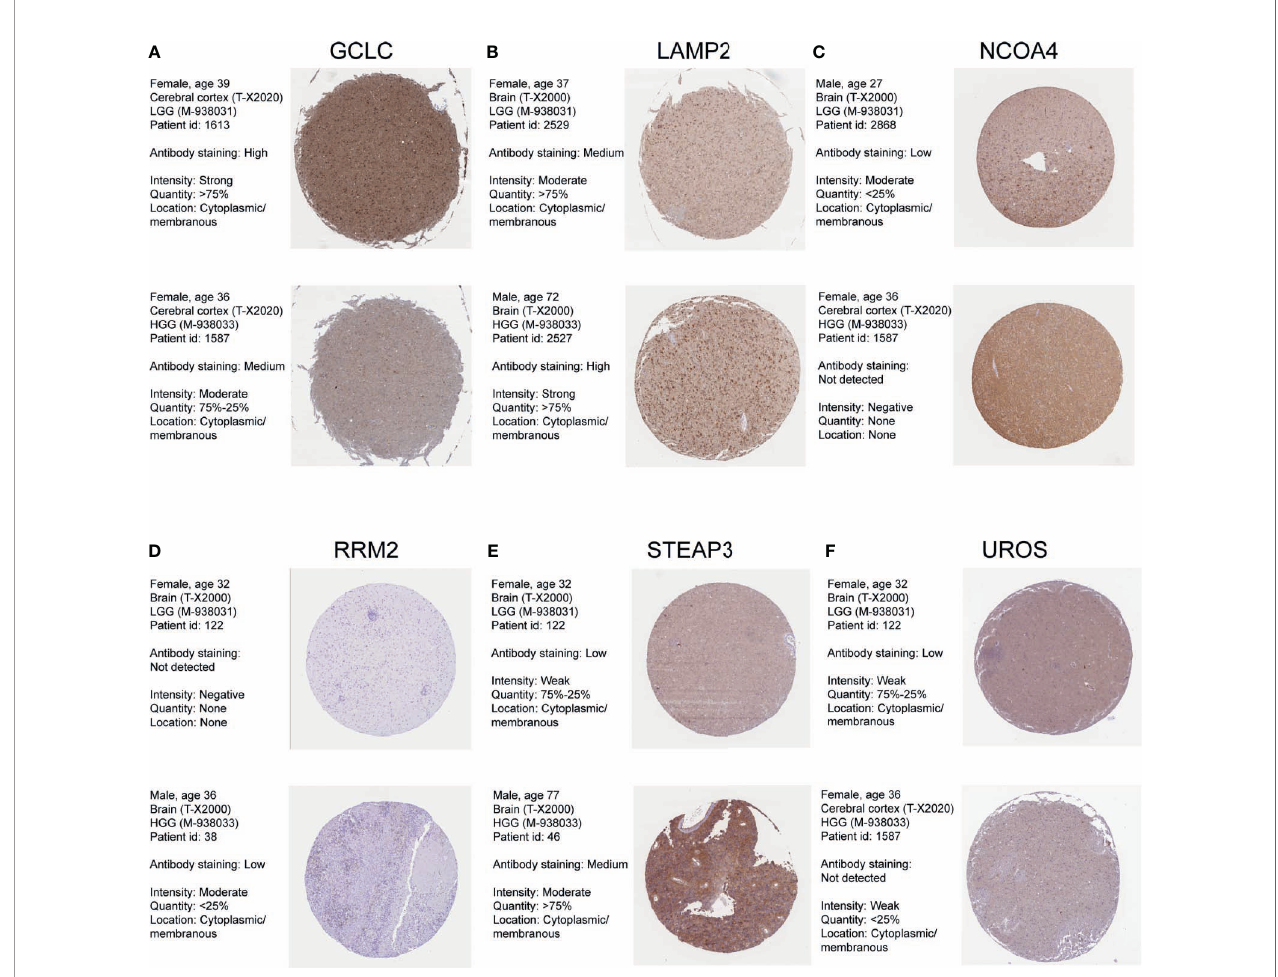
FIGURE 3 | Human Protein Atlas immunohistochemical analysis of LGG and Higher-grade glioma. (A) GCLC; (B) LAMP2; (C) NCOA4; (D) RRM2; (E) STEAP3; (F)